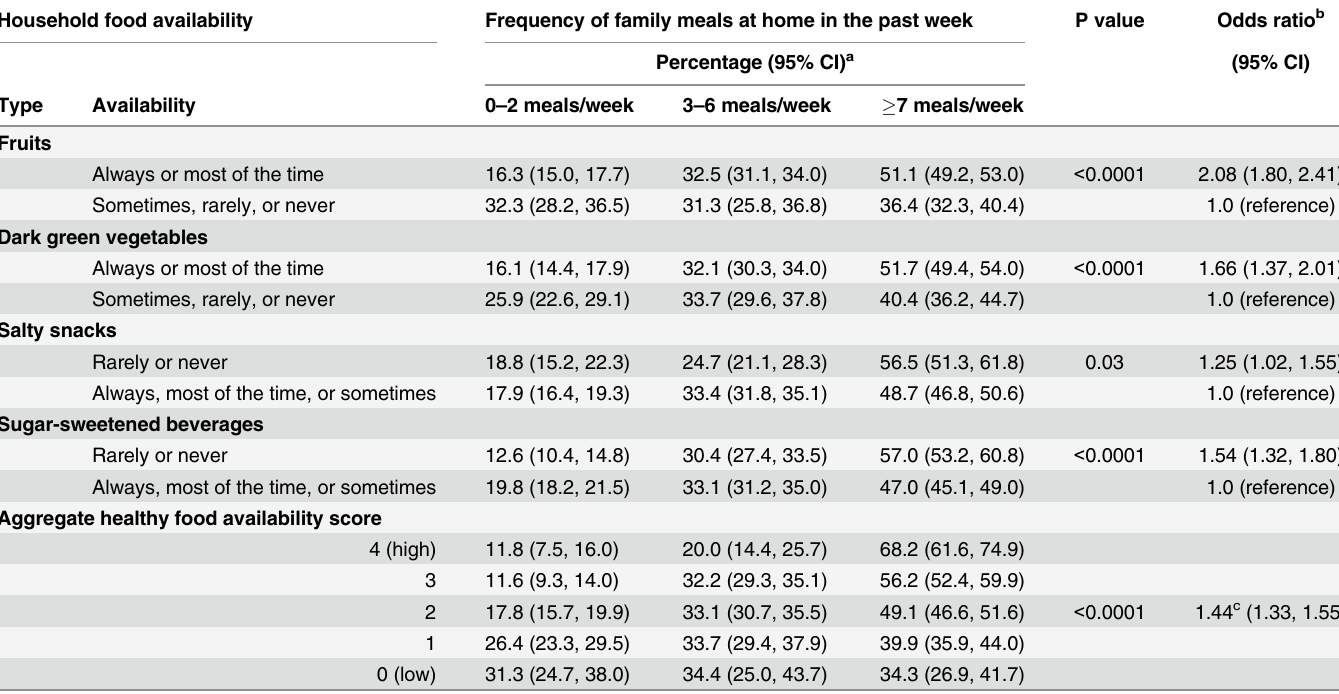
Table 3. Household food availability and family meal frequency in U.S. multi-person households: NHANES 2007 – 10. Household food